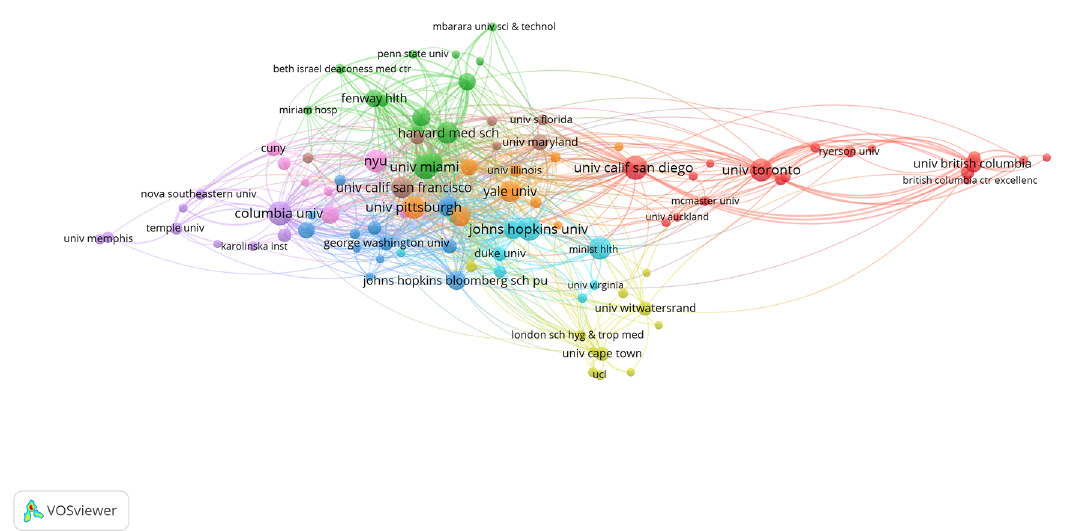
Figure 3. Institutional collaborations on syndemics-related research.